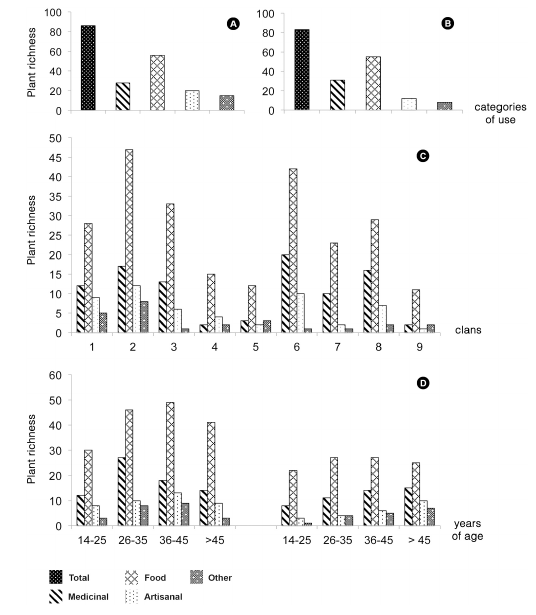
Fig. 2. Richness of plants in different use categories inventoried by village, clan, and sex-age groups. (A) Less isolated village. (B) More isolated village. (C) Clans 1 to 5 from the less isolated village, clans 6 to 9 from the more isolated village. (D) Sex-age group, with women on left and men on